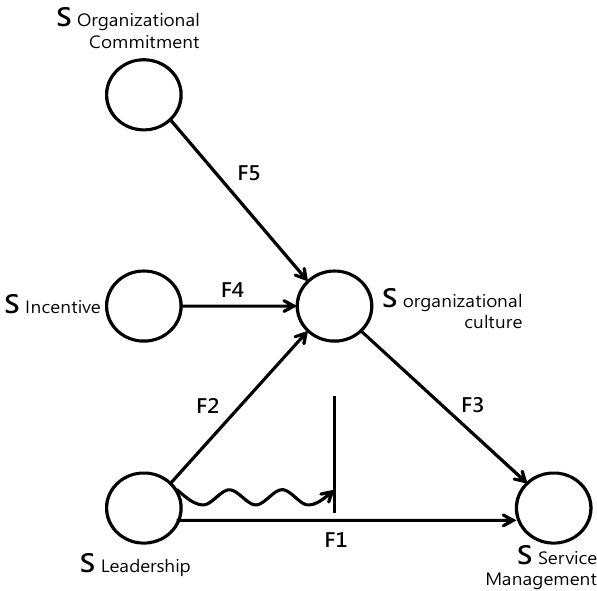
Figure 2. The hypothetical model derived from Su-field analysis.